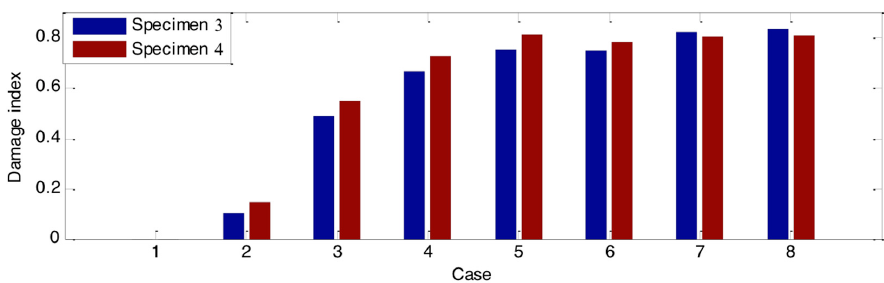
Figure 8. Damage indices of timber with different hole depths.